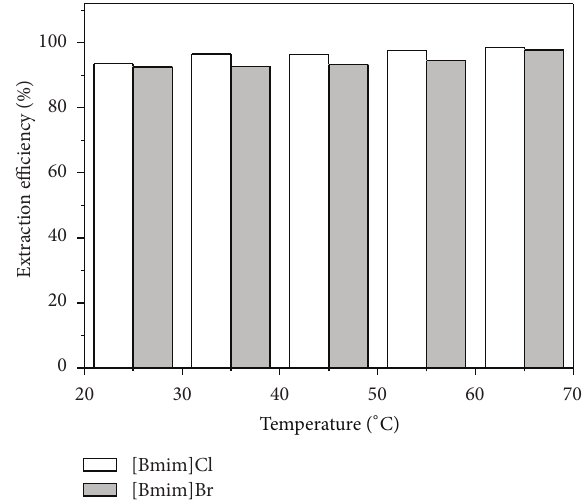
Figure 4: Effect of temperature on the partition coefficients of papain in the ILs+K 2 HPO 4 aqueous two-phase systems (0.8 g K 2 HPO 4 +0.6g ILs + 1.3mL H 2